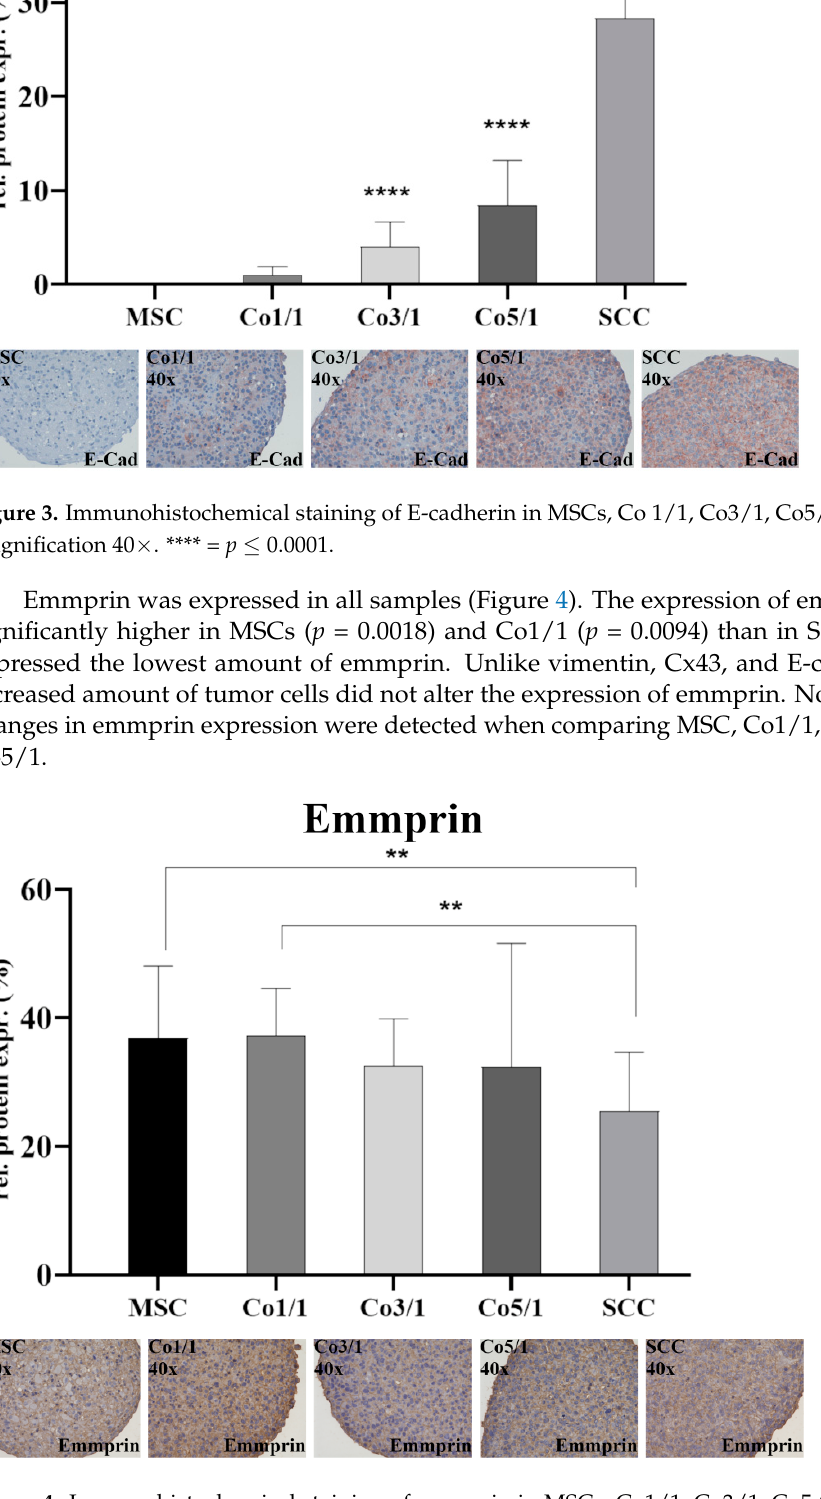
Figure 4. Immunohistochemical staining of emmprin in MSCs, Co1/1, Co3/1, Co5/1, and SCCs; magnification 40×. ** = p ≤ 0.01.